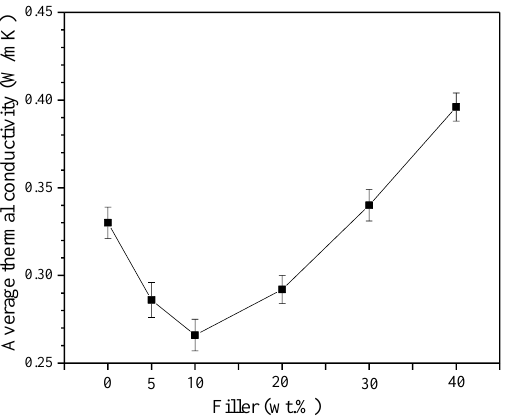
Figure 4. Thermal conductivity of EVA composites as a function of filler amount.